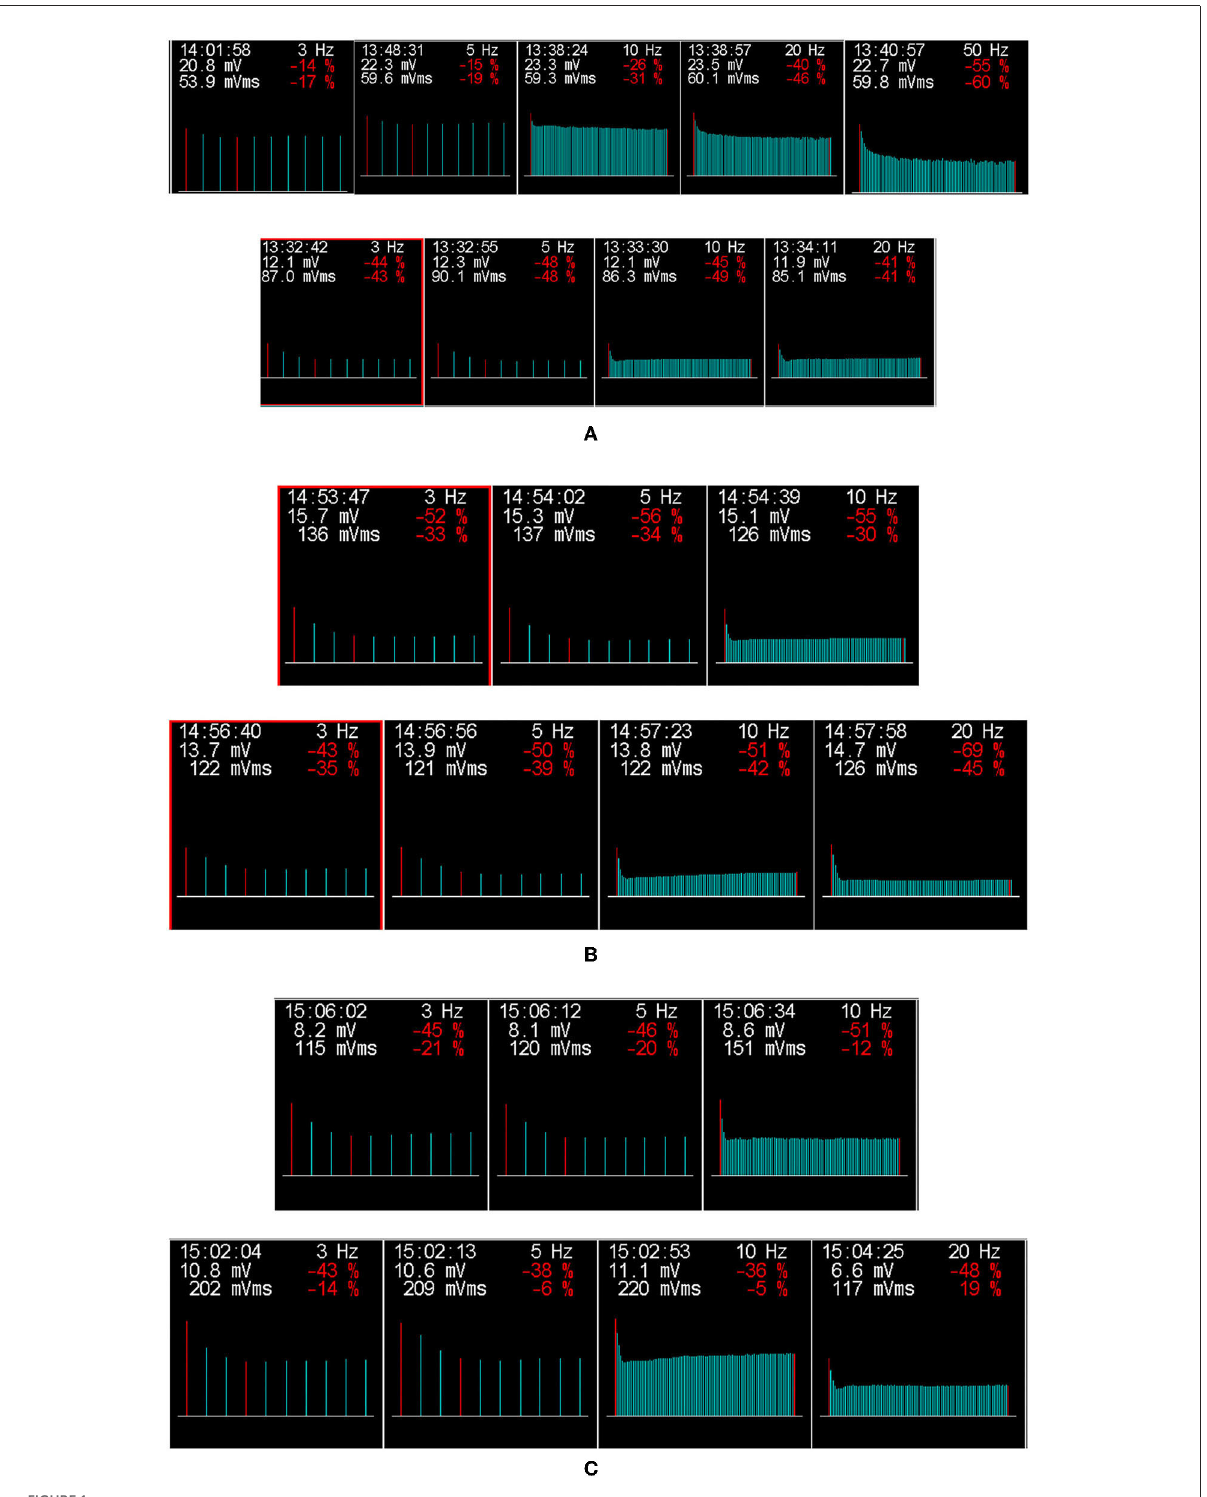
FIGURE1 The results of low-frequency and high-frequency repetitive nerve stimulation (RNS) for three patients with GFPT1-related CMS from southwestern China. The amplitude of compound muscle action potential (CMAP) on RNS at both low-frequency (3, 5HZ) and high-frequency (10, 20, and 50Hz), which decreased by more than 15 and 30%, respectively, are considered abnormal. A dramatic decrement in the right abductor hallucis (top row) on RNS at 5, 20, and 50Hz and in the right trapezius (bottom row) at 3, 5, 10, and 20Hz stimulation was observed in patient 1 (A). Additionally, decremental responses in the right trapezius at 3, 5, and 10Hz (top row) and the left trapezius (bottom row) at 3, 5, 10, and 20Hz were detected in patient 2 (B). In patient 3 (C), RNS in the right trapezius (top row) at 3, 5, and 10Hz and in the left trapezius (bottom row) at 3, 5, 10, and 20Hz showed a decremental response. Repetitive nerve stimulation at low-frequency (3–5Hz) and high-frequency (10–50Hz), producing decremental responses > 15 and 30%, respectively, were considered